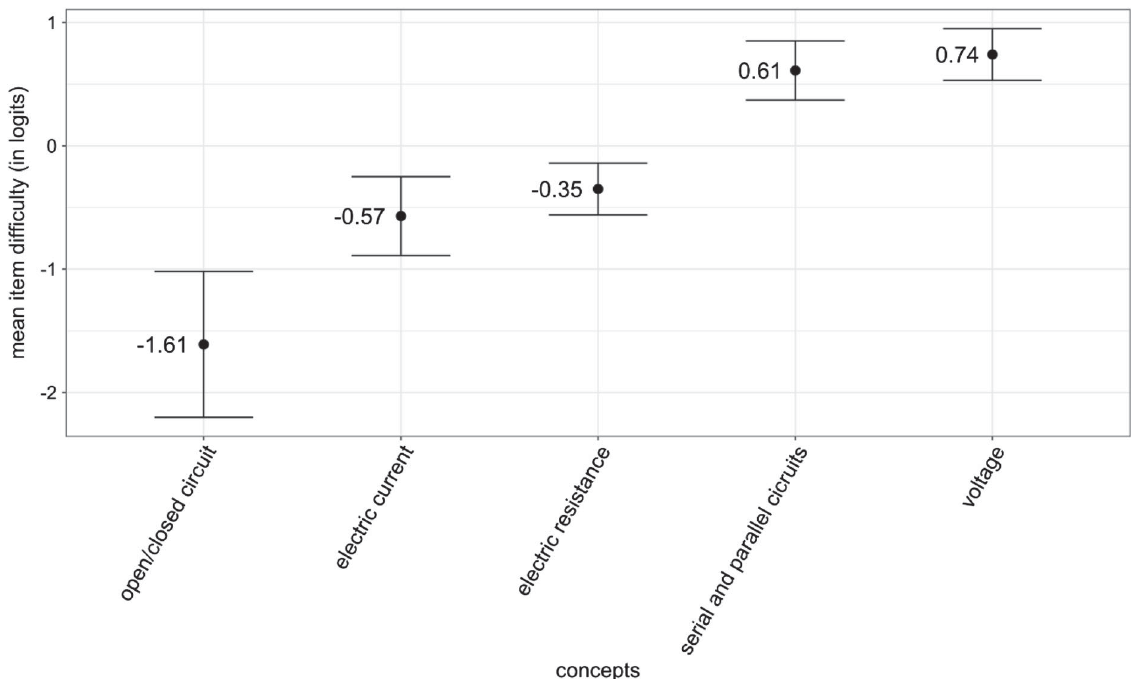
FIG. 11. Average difficulties of different key concepts of electric circuits based on the calculation of the average item difficulty of the items corresponding to each concept. The error bars indicate the combined uncertainties of each average value computed as ffiffiffiffiffiffiffiffiffiffiffiffiffiffiffiffiffiffiffiffiffiffiffiffiffiffi p CE ¼ 1 SEM 2 þ SE 2 , where SEM is the standard error of the mean and SE is the average Rasch standard 4